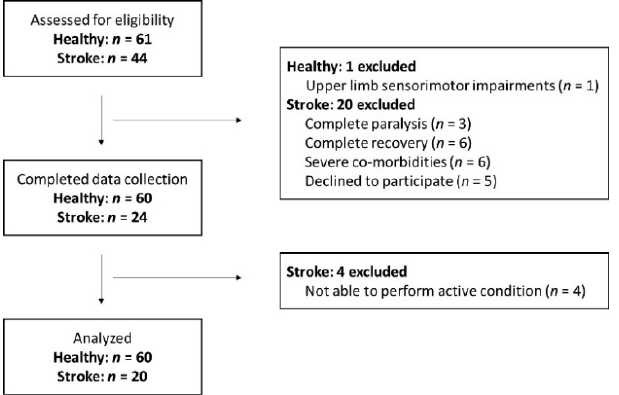
Figure 1. Flowchart of participant inclusion.